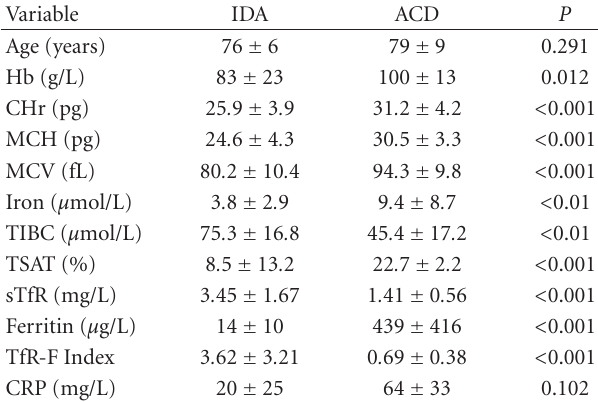
Table 1: Comparison of hematimetric and biochemical iron parameters and CRP between patients with IDA and ACD. Data are expressed as means ± SD. IDA, iron deficiency anemia; ACD: anemia of chronic Disease; CHr: reticulocyte hemoglobin content; MCH: mean corpuscular hemoglobin; MCV: mean corpuscular volume; TIBC: total iron binding capacity; TSAT: transferrin saturation, sTfR: soluble transferrin receptor; TfR-F Index, sTfR/log Ferritin; CRP, C-Reactive Protein.